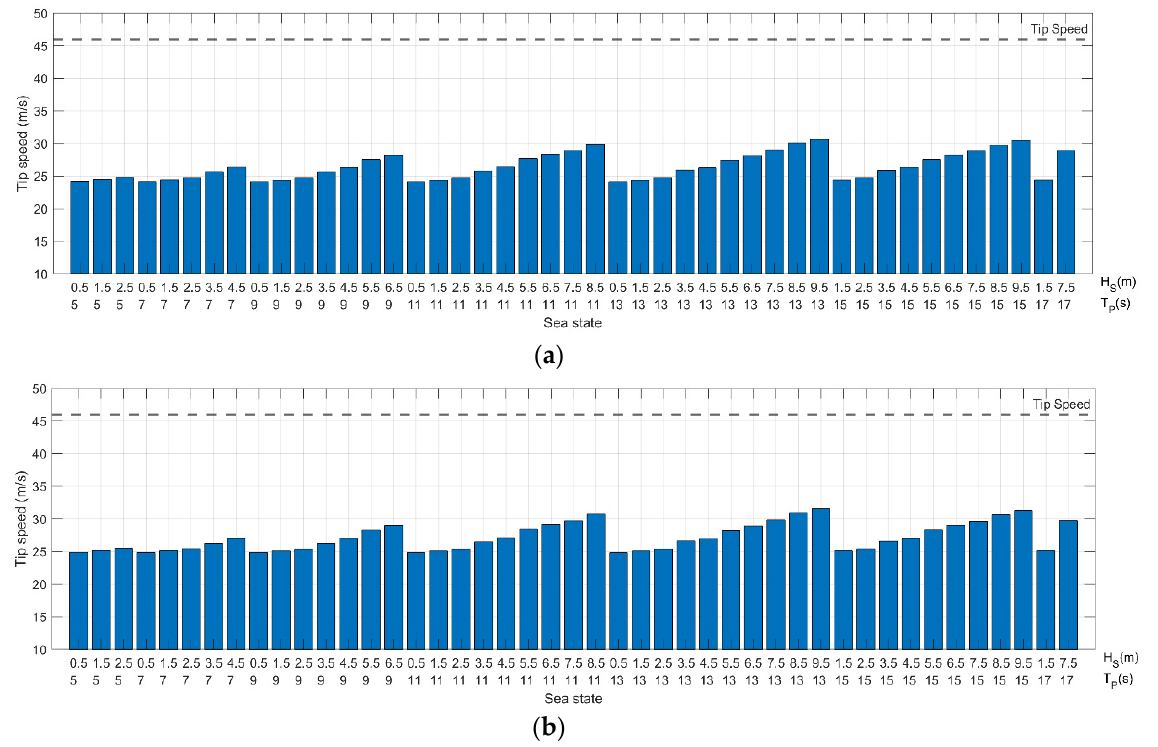
Figure 14. Variation of tip speed for different sea states. Hull roughness: ( a ) 0.15 mm; ( b ) 0.55